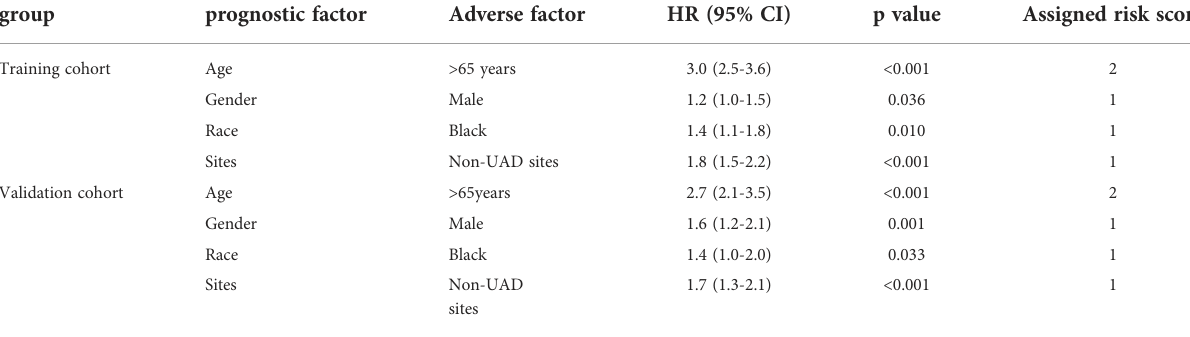
HR, Hazard ratio; CI, con fi dence interval; UAD, upper aerodigestive tract.